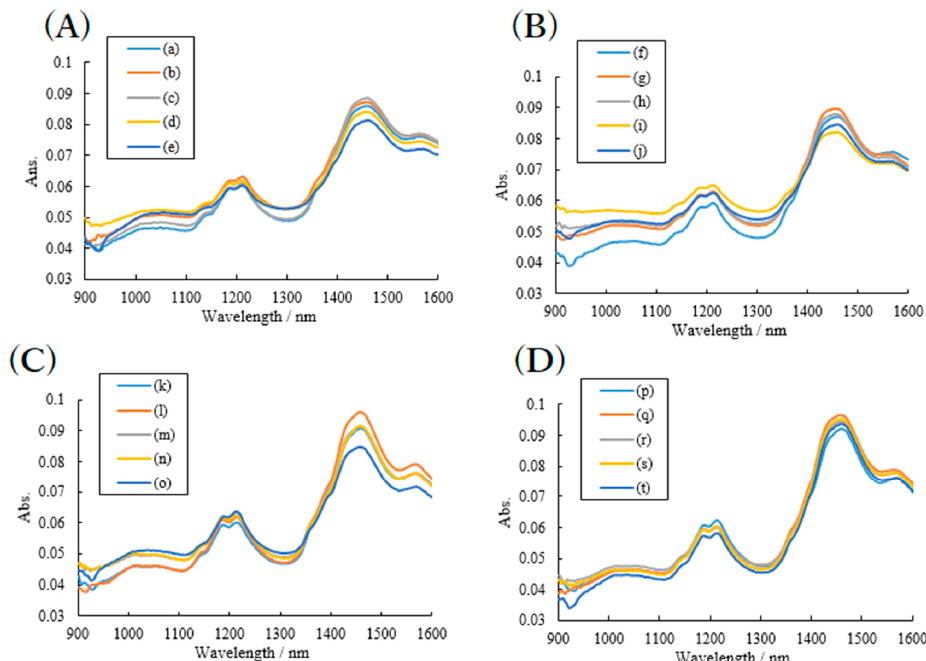
Figure 10. Near-infrared spectra of stored samples. Ground mixture RB, SDS and HPC-SSL (RSH) sample stored in RH 30% ( A ) and RH 75% ( B ). Physical mixture RSH samples stored in RH 30% ( C ) and